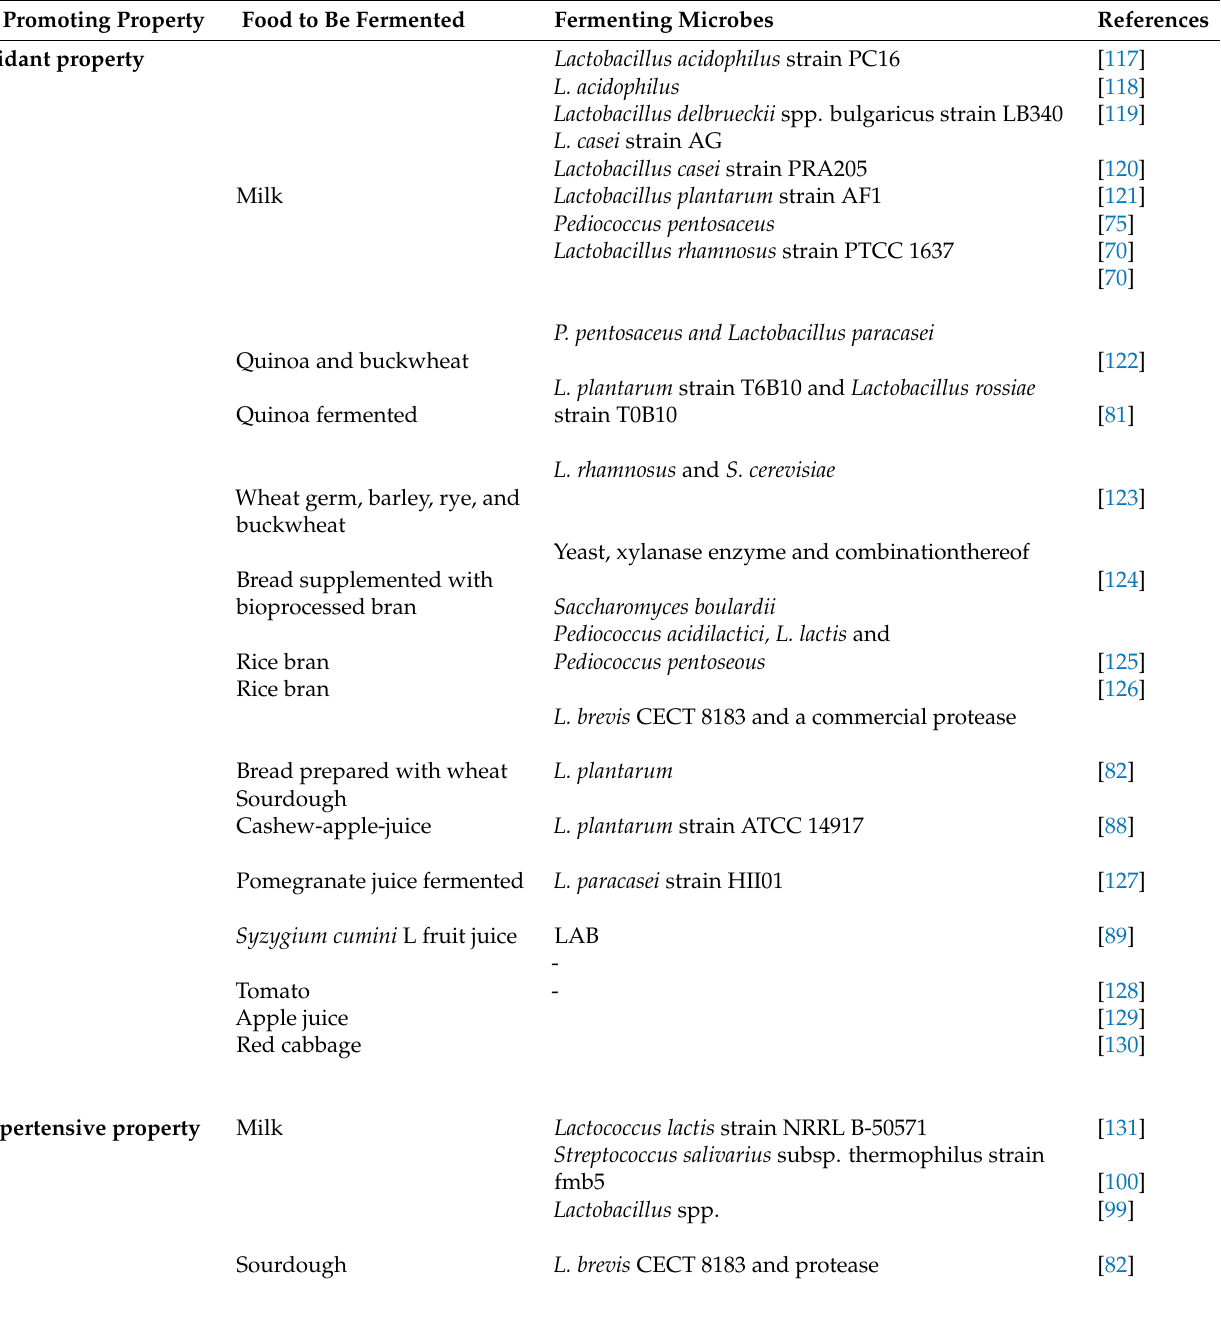
Table 1. Fermented foods and their health promoting